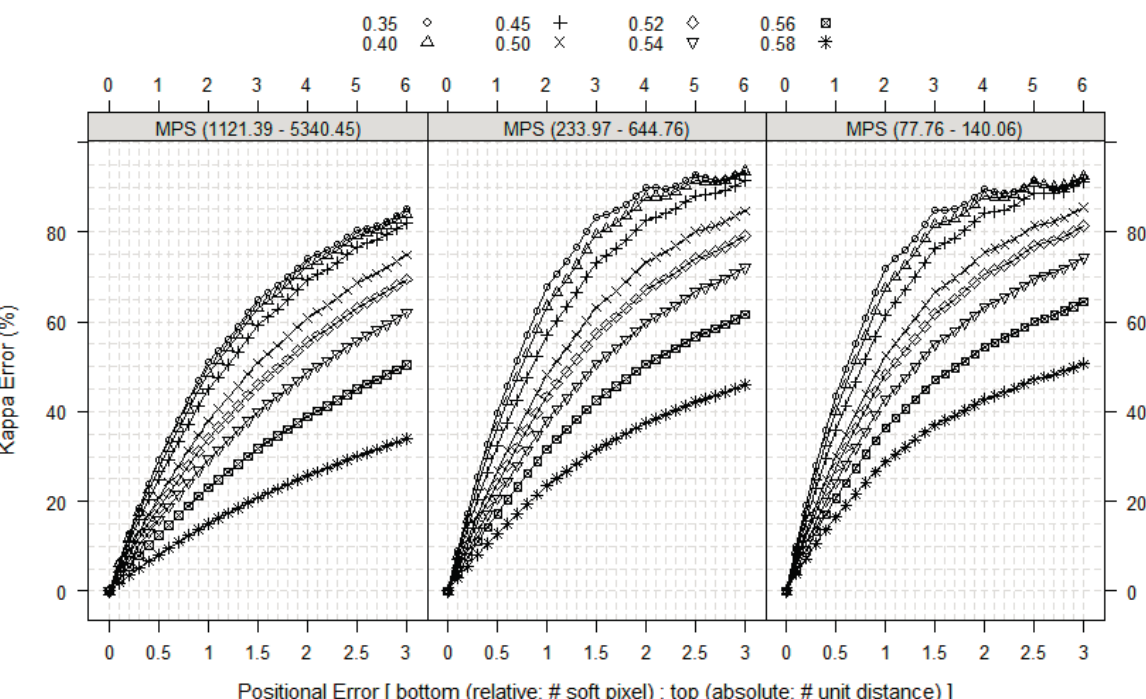
Figure 7. Impact of positional error on kappa-error at different landscape characteristics using a spatial resolution of 1 unit distance.